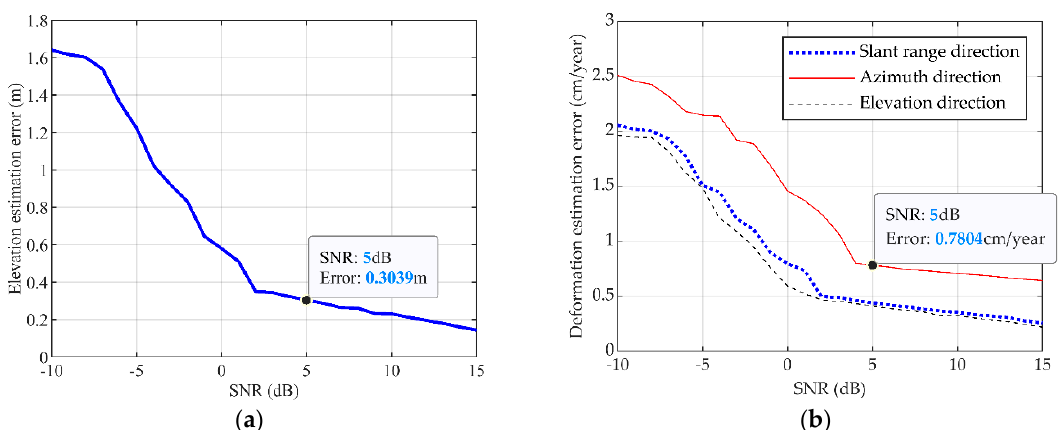
Figure 7. Average estimation errors of elevation and 3-D deformation velocities. ( a ) Average estimation error of elevation. ( b ) Average estimation errors of 3-D deformation velocities in slant range, azimuth, and elevation directions. Table 10. Elevation and 3-D deformation retrieval errors in different signal noise ratios (SNRs).